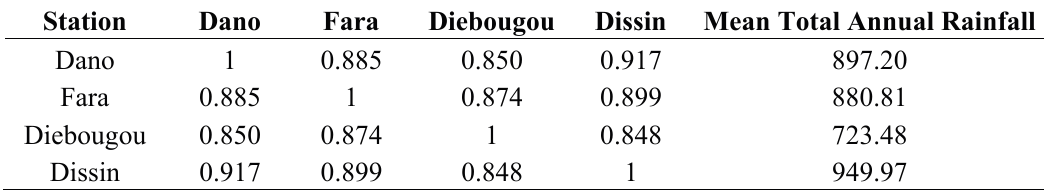
Table 3. Correlation matrix of stations and mean total annual